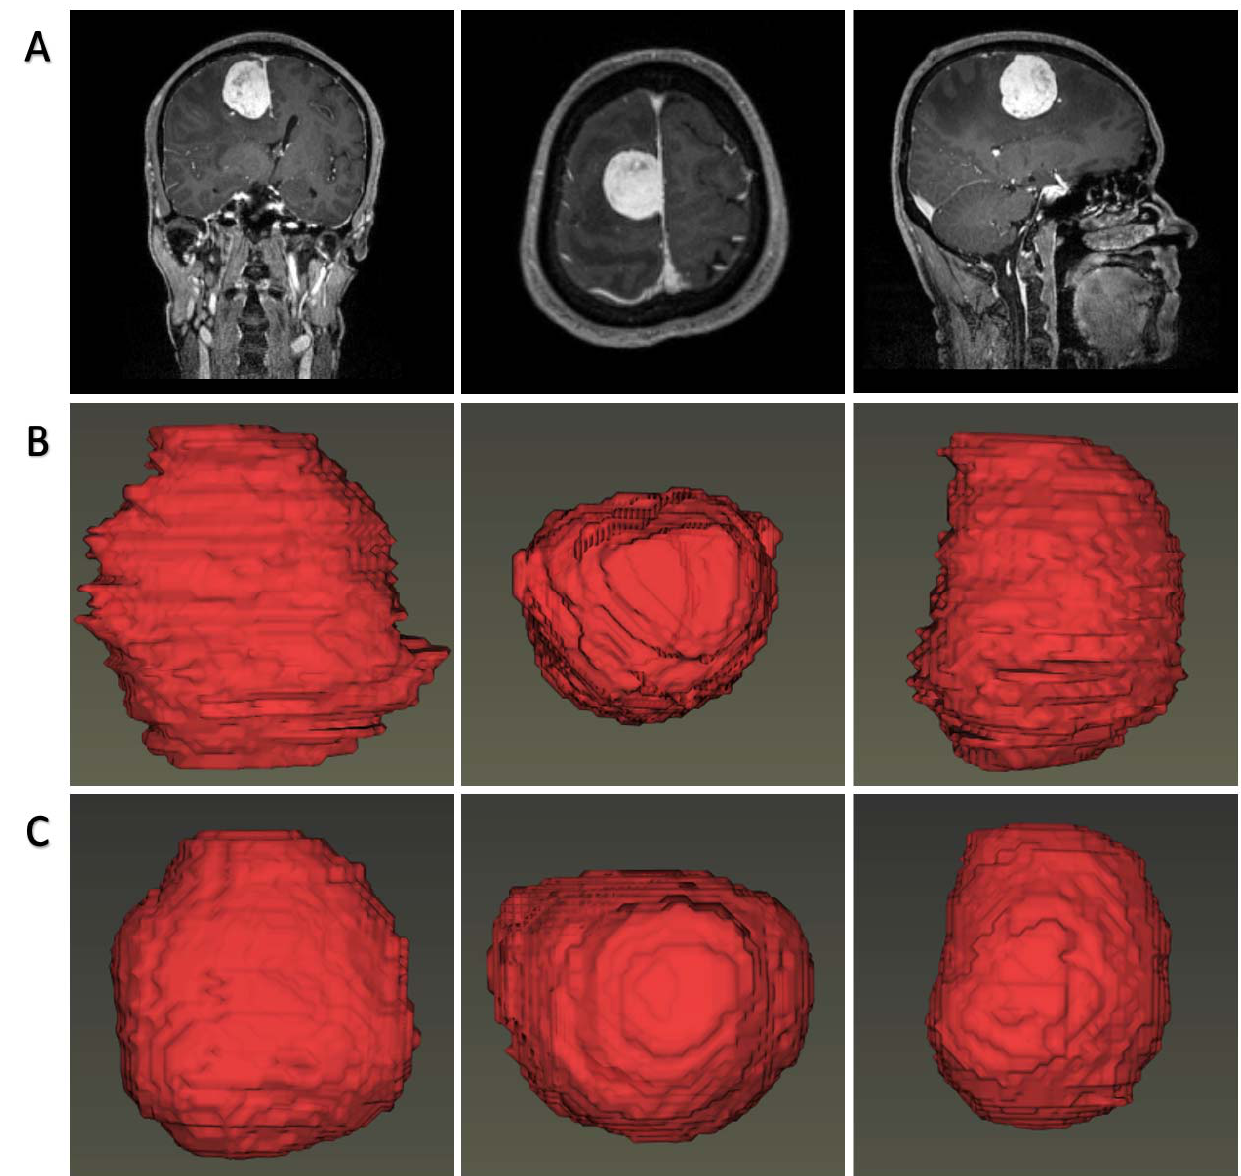
Figure 3. Visualized tumor reconstructions by automatic predicted labels and human-noted labels. ( A ). original MR images; ( B ). tumor rendering with human-noted labels; ( C ). tumors rendering with automatic predicted labels.